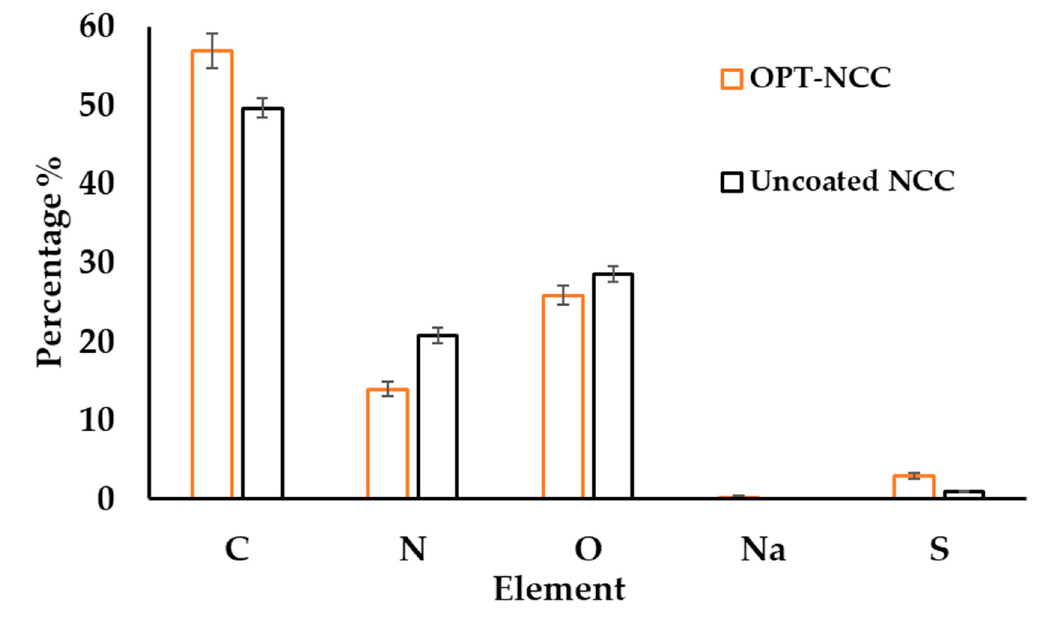
Figure 5. Elemental analysis of uncoated (black) and OPT-NCC (orange).